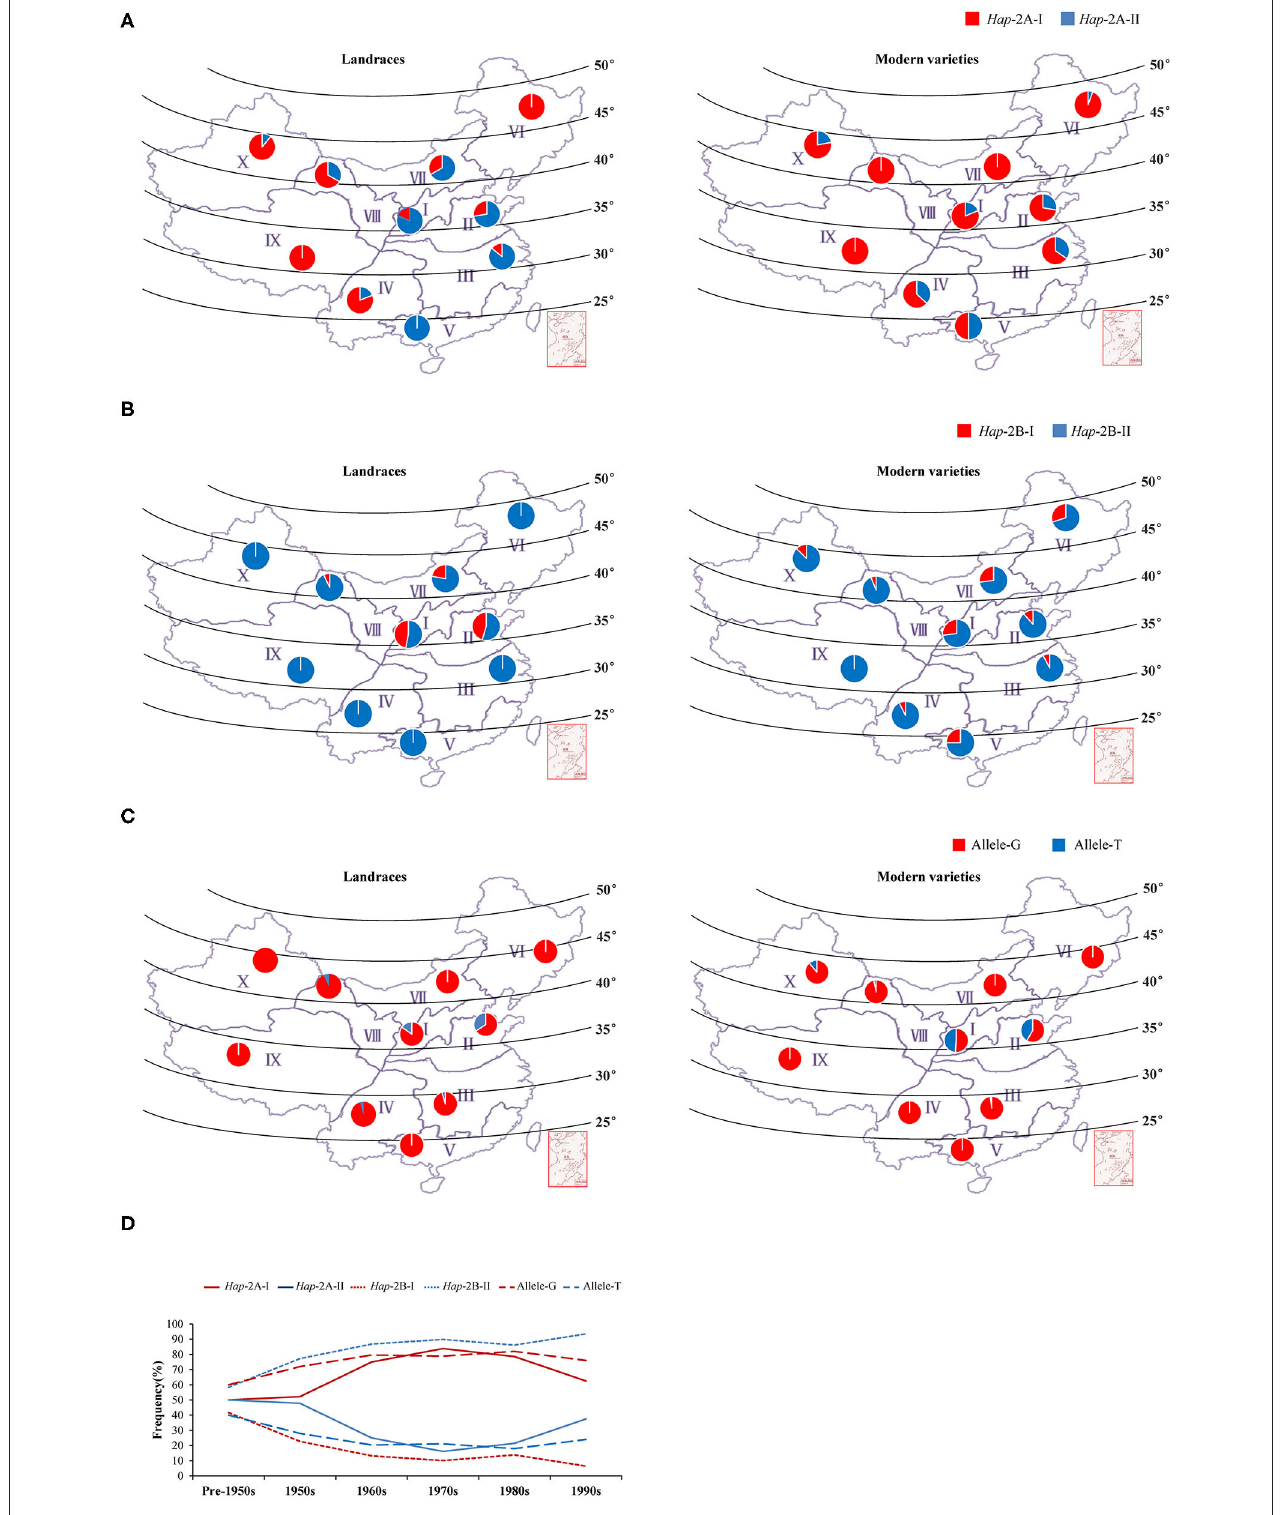
FIGURE 6 | Geographic and temporal distributions of the haplotypes/alleles for TaWRKY51s in the Chinese landraces and modern cultivars in the 10 wheat zones. Geographic distributions of the haplotypes for TaWRKY51-2A (A) , -2B (B) , and -2D (C) in the Chinese landrace and modern variety populations. The frequency alterations for the haplotypes/alleles of TaWRKY51s in modern varieties were released in different time periods in China (D) .